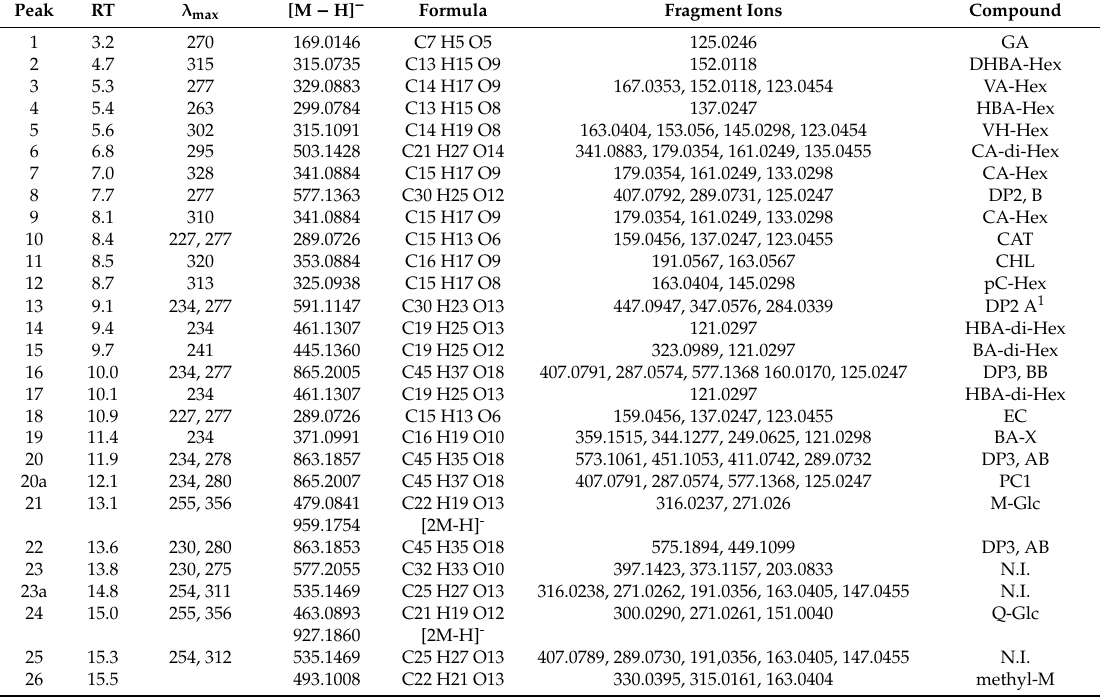
Table 2. Compounds identified in the analyzed commercial cranberry extracts (A1-A3). For each compound is reported the retention time (RT, min), λ max (nm), HR mass of the deprotonated ion [M-H] - , molecular formula, and fragment ions [M − H] −